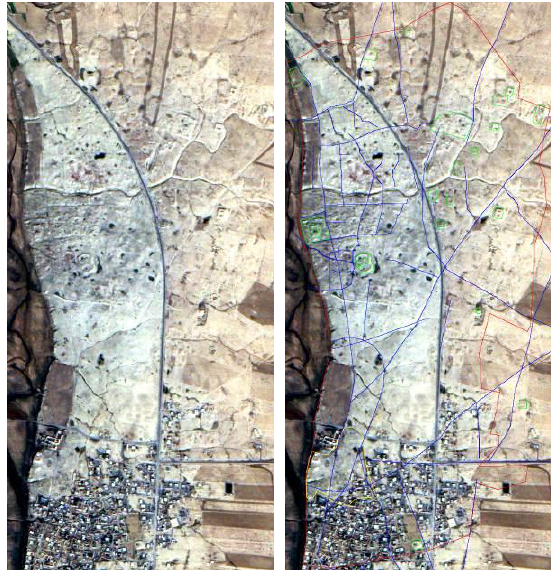
Figure 5 – Al-Hadítha – a RGB synthesis of the FORMOSAT- 2 image (acquired on 24. 10. 2014) with an overlaid objects of interest on the right picture (Cemetery – yellow, city outline – red, features found on site – green, historic routes – blue).